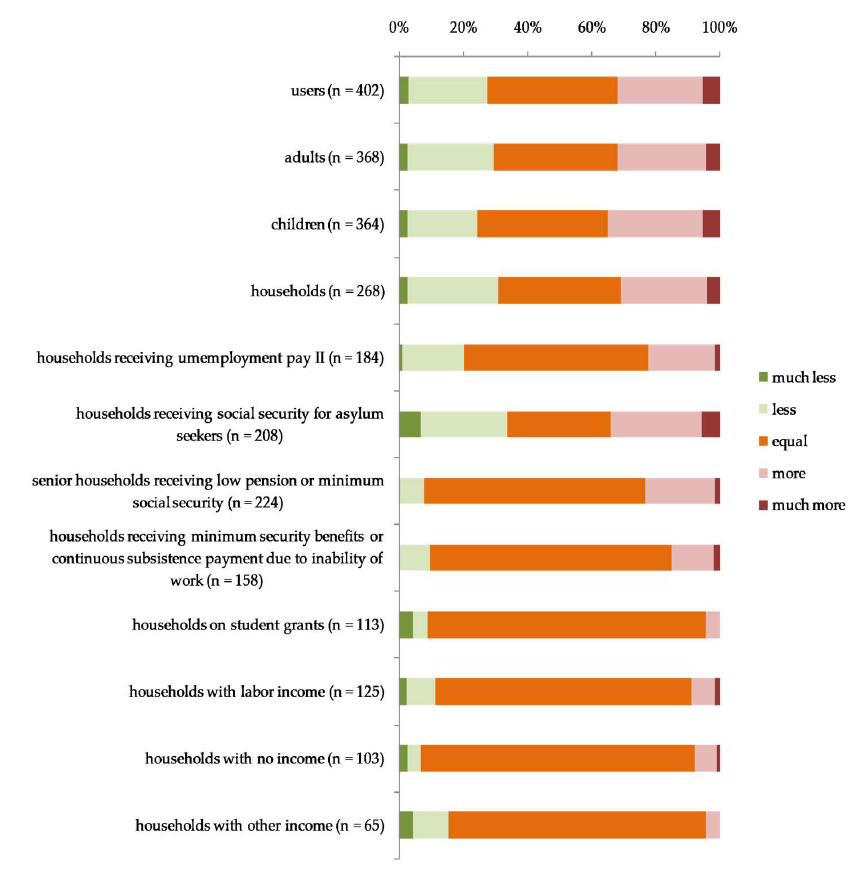
Figure 2. Comparison of the number of users of participating food banks per month in 2017 and 2016 in percent of participating food banks.